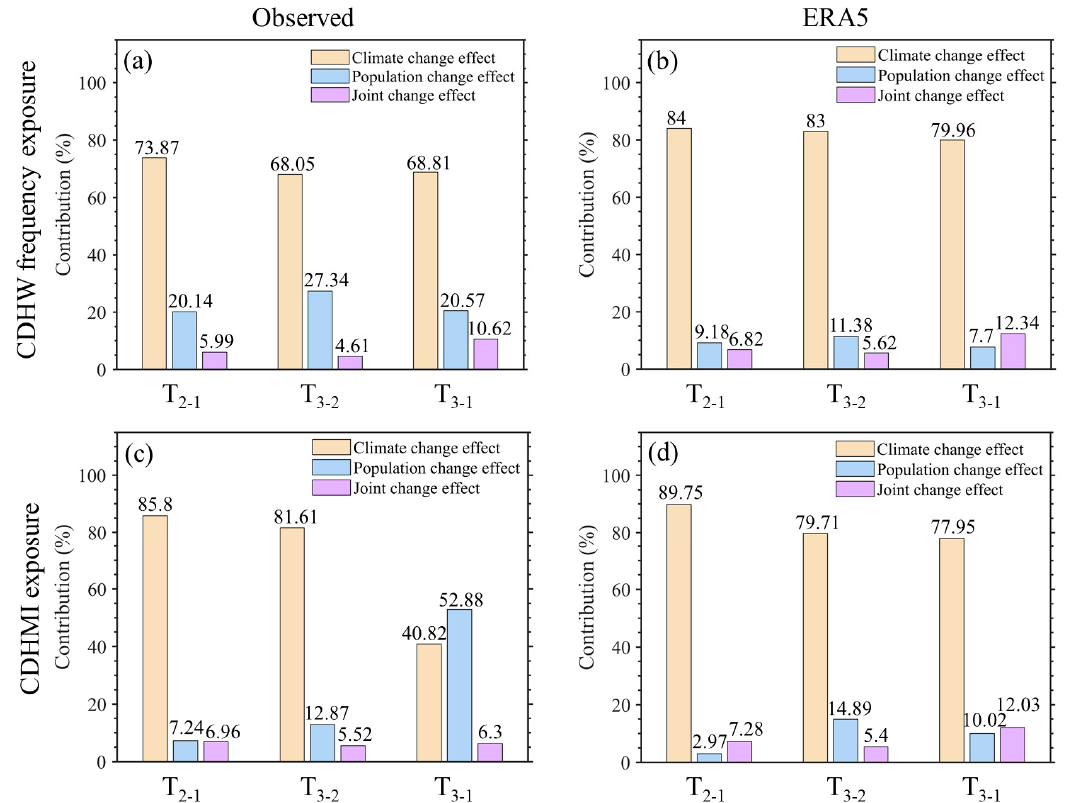
Figure 13. Decomposition of the change in population exposure to ( a , b ) CDHW and ( c , d ) CDHMI in the GRB. T 2-1 , T 3-2 , and T 3-1 represent the contributions of changes in 1999–2008, 2009–2018, and 2009–2018 relative to 1989–1998, 1999–2008, and 1989–1998, respectively.